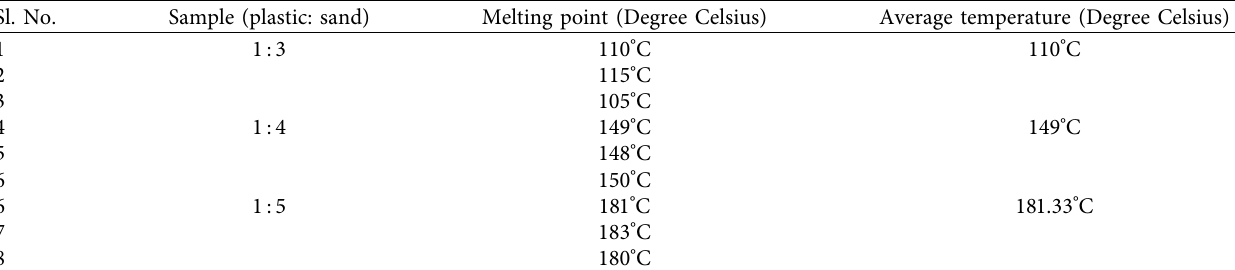
Table 7: Thermal resistance test on different ratios of plastic and sand. Sl.